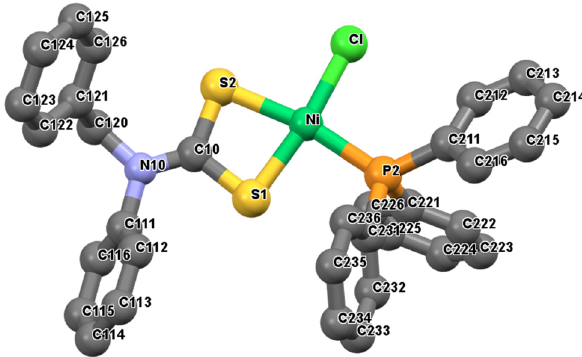
Figure 11: Molecular structure of [ Ni ( P ( phenyl ) 3 ( S 2 CN ( phenyl ) ( benzyl ) Cl ] . Redrawn from ref. [ 47 ] , with permission from Elsevier ( Copyright 2020 ) .